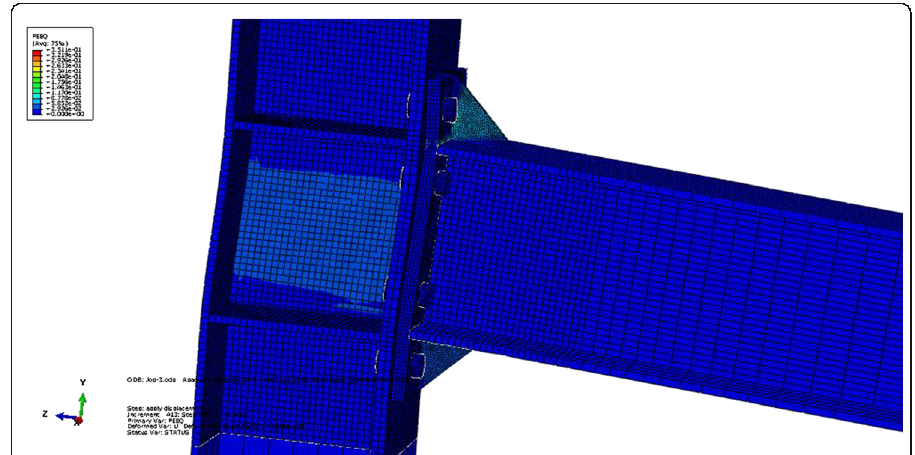
Fig. 18 Strain distribution for connection SC2 at failure